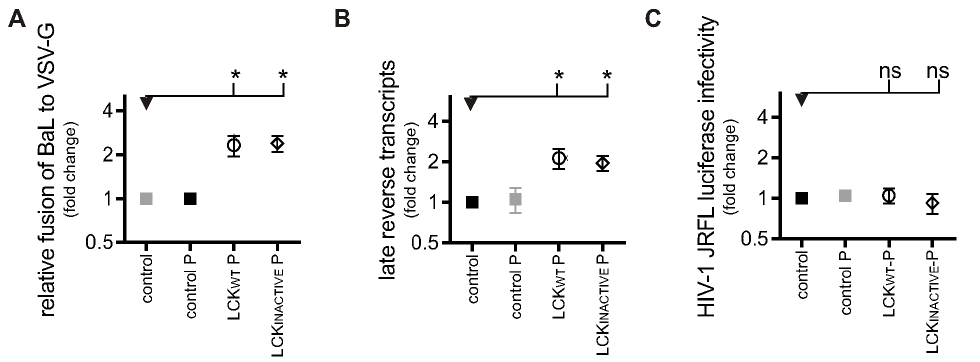
Figure 2. Increased HIV-1 entry in LCK + macrophages results in increased reverse transcription, but not successful infection. A) HIV-1 viral fusion in PSC-macrophages. The percentage of fusion of HIV-1 virions was normalised to the percentage fusion of VSV-G pseudotyped virions. Symbols represent the normalised mean fusion, relative to the PSC-macrophages control group 6 SEM of independent experiments. Control-, LCK WT P and LCK INACTIVE P (n=3) and control P PSC-macrophages (n=1). B) Reverse transcription of HIV-1 in PSC-macrophages. Late (pol) products were detected by qPCR after 30 h of infection. Symbols represent the relative mean number of copies of HIV-1 DNA 6 SEM of independent experiments (n=3), normalised to the number of cells using a b -actin control. C) HIV-1 productive infection in PSC-macrophages. Infection was measured by detecting luciferase activity in PSC-macrophages three days after transduction with NL4.3.Luc.R-E- virus pseudotyped with HIV-1 or VSV-G envelope. HIV-1 NL4.3.Luc.R-E- transduced cells were normalised to VSV-G NL4.3.Luc.R-E- transduced cells. Symbols represent the mean luciferase detection relative to the PSC-macrophages control group 6 SEM of independent experiments (n=3).